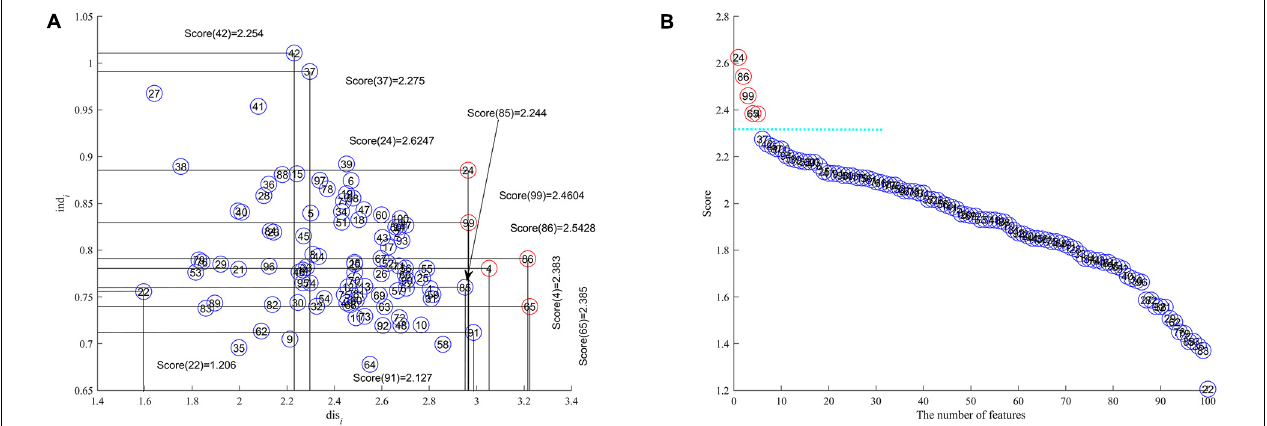
FIGURE 1 | The toy case to test SCFS, (A) discernibility and independence are x -coordinate and y -coordinate respectively, (B) the number of features is the x axis and feature score the y axis respectively.